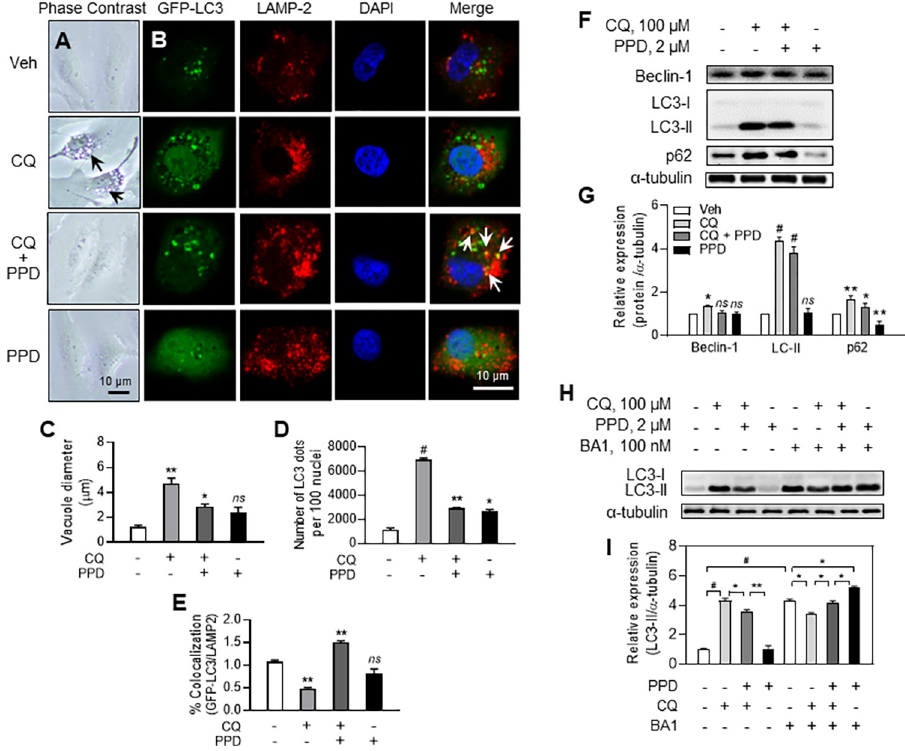
Fig 3. Protopanaxadiol (PPD) enhances liberation of adult retinal pigment epithelial (ARPE)-19 cells from chloroquine-induced autophagy congestion. (A) Phase-contrast photomicrograph of ARPE-19 cells. Large vacuoles in cells treated with CQ for 6 h (black arrows). (B) Confocal images of green fluorescent protein (GFP)-light chain 3 (LC3, green)-transfected cells immunostained with lysosomal membrane-associated protein (LAMP)-2 (red) antibody. Cells treated with vehicle, 100 μ M CQ, 2 μ M PPD, or 2 μ M PPD+100 μ M CQ for 6 h. 4’,6-Diamidino-2-phenylindole (blue) counterstained nuclei. Scale bar, 10 μ m. Quantification of GFP-LC3-transfected ARPE-19 cells to analyze LC3-positive vacuole (C) size, (D) number (green), and (E) number of LC3-positive (green) vacuoles colocalized (yellow, white arrows) with LAMP-2 (red). (F, H) Western blotting (WB) and (G, I) densitometric analysis of Beclin-1, LC3-II, and p62 in the ARPE-19 cell lysates 6 h after treatment with drugs as in (A). Protein expression levels were compared to levels of α -tubulin and values under blots indicate relative protein expression levels determined by densitometric analysis, unless otherwise specified. Data are means ± standard deviation (SD), n = 3; ns ; not significant, � P < 0.05, �� P < 0.01 and # P < 0.001 vs each control.